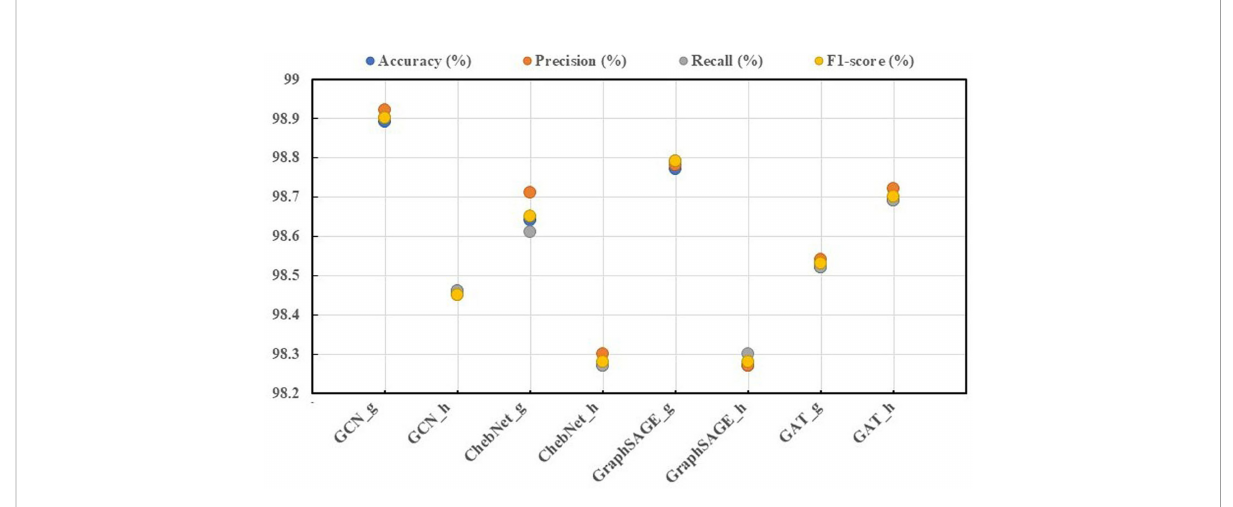
FIGURE 4 Fish appetite grading results of different GNN-based methods.